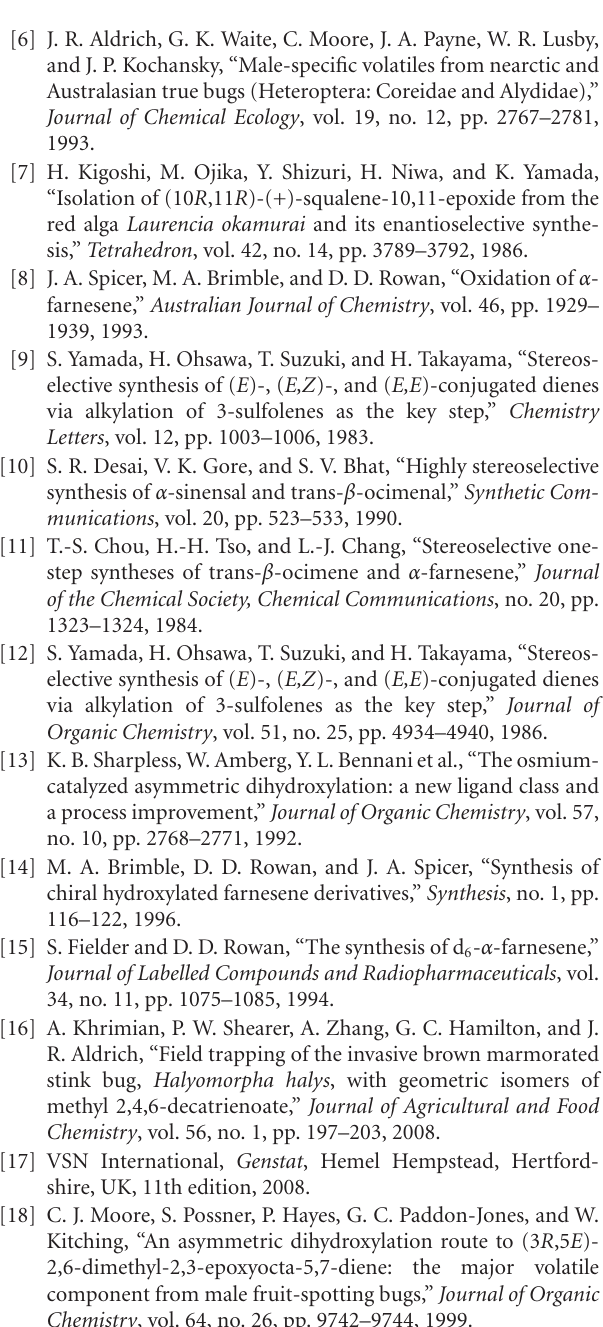
Table 1: Mean numbers of A mblypelta lutescens lutescens trapped in a mango crop in north Queensland by sticky panels containing 3- and 4-component pheromone lures over a 4-day period in October 2011. Mean no. of A . lutescens lutescens /trap/day ( ± SE) Panel traps Total bugs caughtAdults Nymphs Total ♂♂ ♀♀ 3-component lure 0.45 ( ± 0.16) a 0.25 ( ± 0.08) a 0.20 ( ± 0.09) a 0.90 ( ± 0.23) a 18 4-component lure 0.15 ( ± 0.10) ab 0.20 ( ± 0.05) a 0.10 ( ± 0.06) ab 0.45 ( ± 0.12) a 9 Untreated control 0 b 0 b 0 b 0 b 0 Means within columns followed by the same letter are not significantly di ff erent at P = 0 .